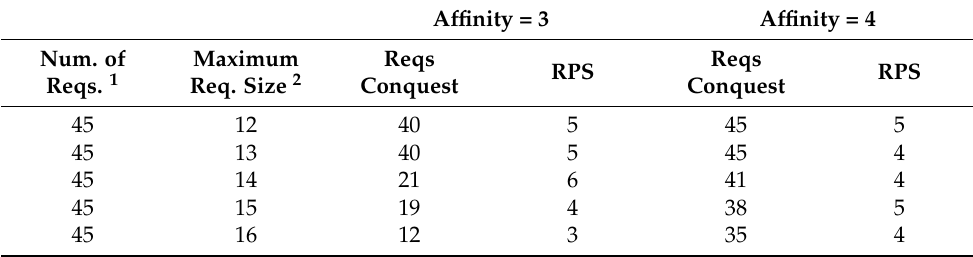
Table 10. Impact of Requirements size and Affinity Parameter in global results using HWsw_1